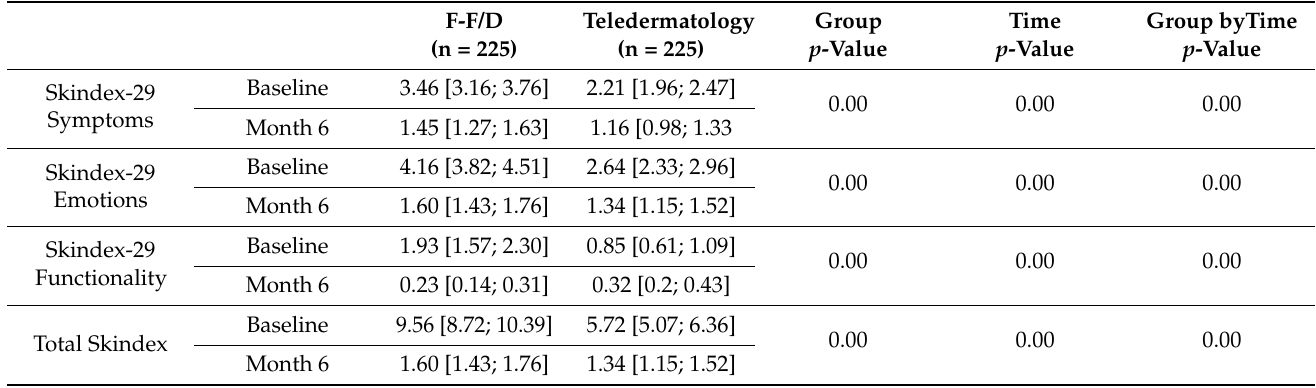
Table 6. Repeated measures design with group and time as fixed effects across